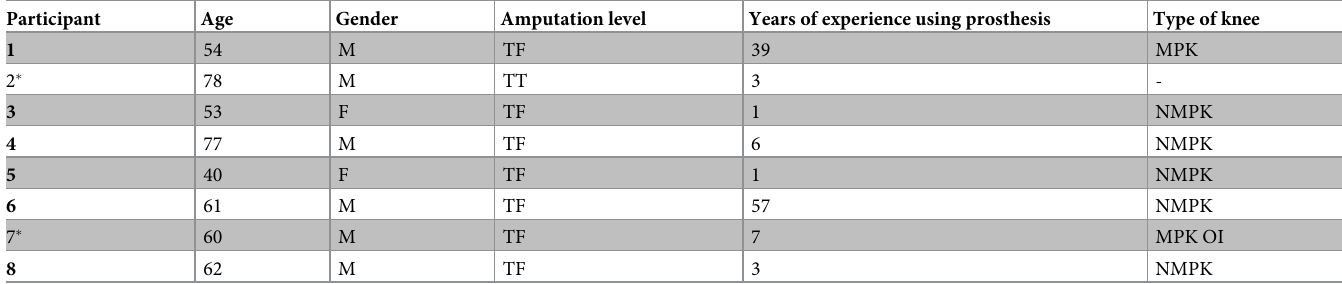
Table 3. Demographics of focus group